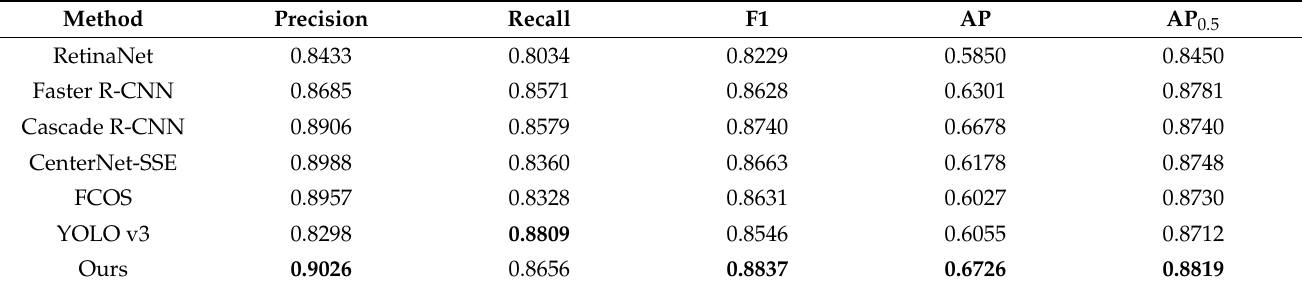
Table 11. Comparison results of CNN-based detectors on the HRSID